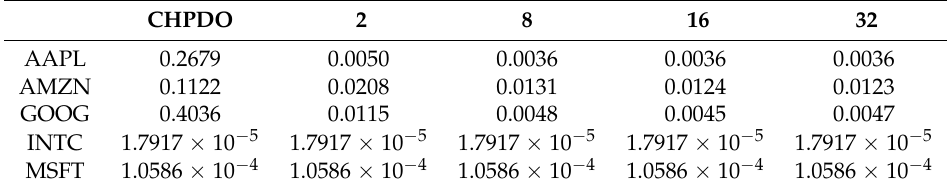
Table 8. We list the mean residuals for several Markov chains with varying numbers of states. These were generated using our modified quantile approach choosing to start with 2, 8, 16 or 32 quantiles. We see that, in general, the mean residual decreases to some lower limit where we can no longer perform any better. Recall that the only observed mid-price changes for INTC and MSFT were of a half tick size, and any increase in the number of quantiles will result in the same performance. CHPDO 2 8 16 32 AAPL 0.2679 0.0050 0.0036 0.0036 0.0036 0.1122